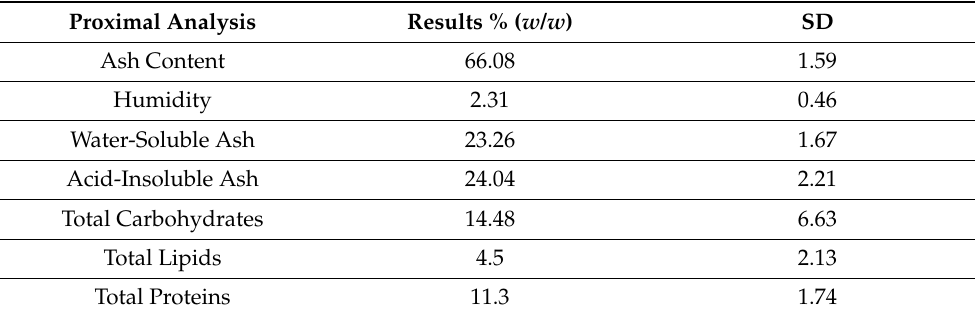
Table 1. Proximal analysis of J. rubens .